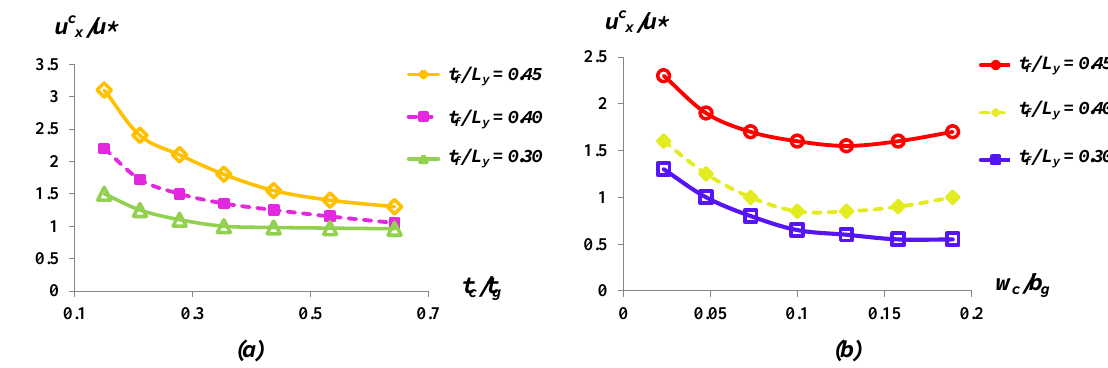
Figure 6. Variation of u c x / u ∗ as a function of ( a ) t c / t g in the range 0.2 (cid:54) t c / t g (cid:54) 0.68 and ( b ) w c / b g in the range 0.03 (cid:54) w c / b g (cid:54) 0.2 for different values of t f / L y .